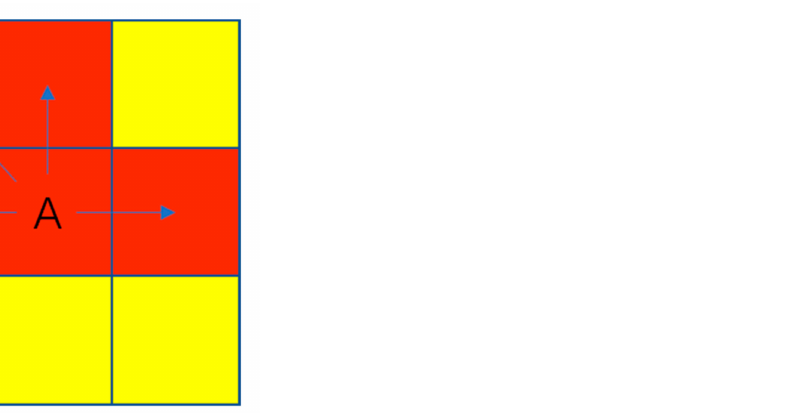
Figure 5. Thefour-wayoptimizationlabeledgraphoftheImprovedEight-ConnectedExtractionAlgorithm. After the first marking is completed, the image undergoes a second assessment process and is scanned from left to right and top to bottom to find the marked point. Each marked cell is reevaluated to determine whether the attribute value is the same at the four other direction points (i.e., upper right, lower right, lower left, and bottom). If so, the final mark will be carried out [45–47]. As shown in Figure 6, both A and B meet the four-way optimization requirements and are marked accordingly. After all the cells are marked for the first time, the marked points undergo the second assessment procedure. In the example, only point A meets the requirement and is marked accordingly. On the other hand, Point B does not meet the second screening procedure, which means no further processing will be done on the cell.